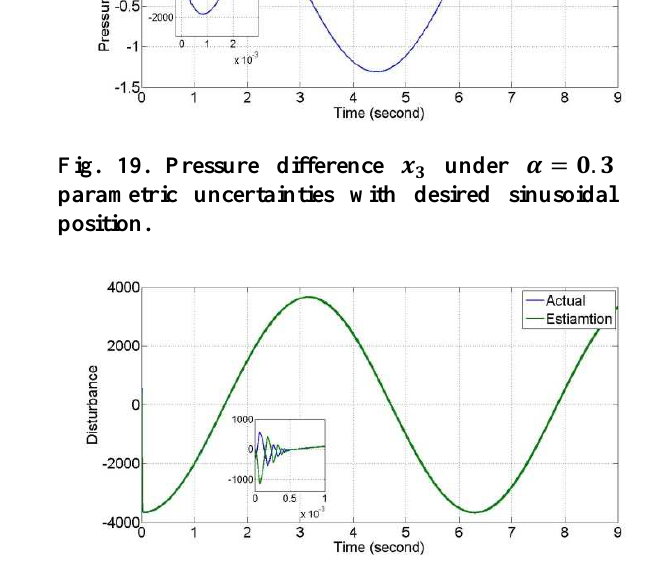
estimation under ¢